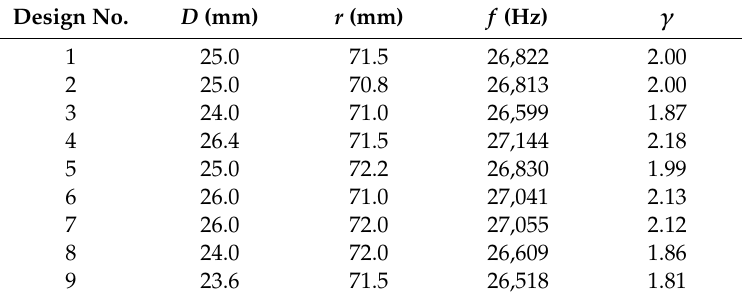
Table A3. CCD design table and the relevant FE analysis results (Type 3). Design